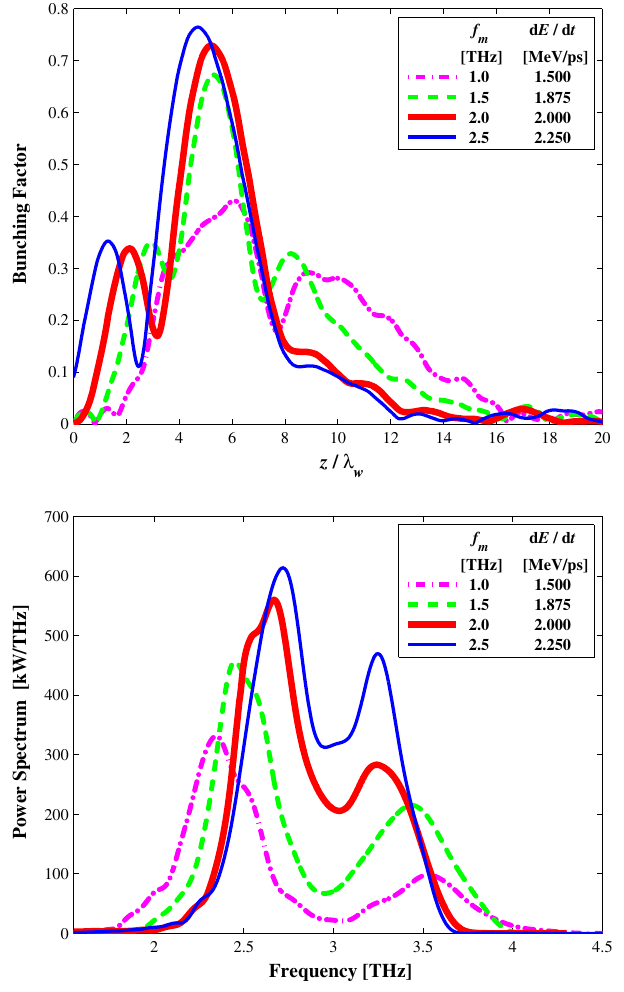
FIG. 12. The bunching factor h exp ð jw s t Þi at the FEL synchro- nism frequency (top) and the power spectrum (bottom), obtained with short N m ¼ 2 long premodulated, energy chirped beam pulses. The beam charge is Q b ¼ 1 nC, the initial modulation depth is m ¼ 50%